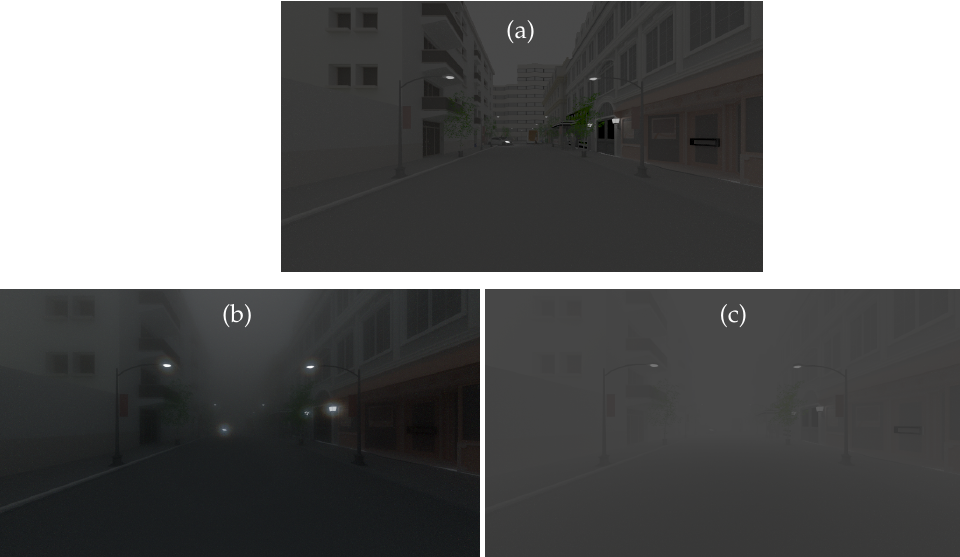
Figure 7. Simulated images for the intra-urban scene with the SWEET simulator without fog ( a ) and with fog (MOR = 20 m, ( b )) and with the Koschmieder model ( c ) in night